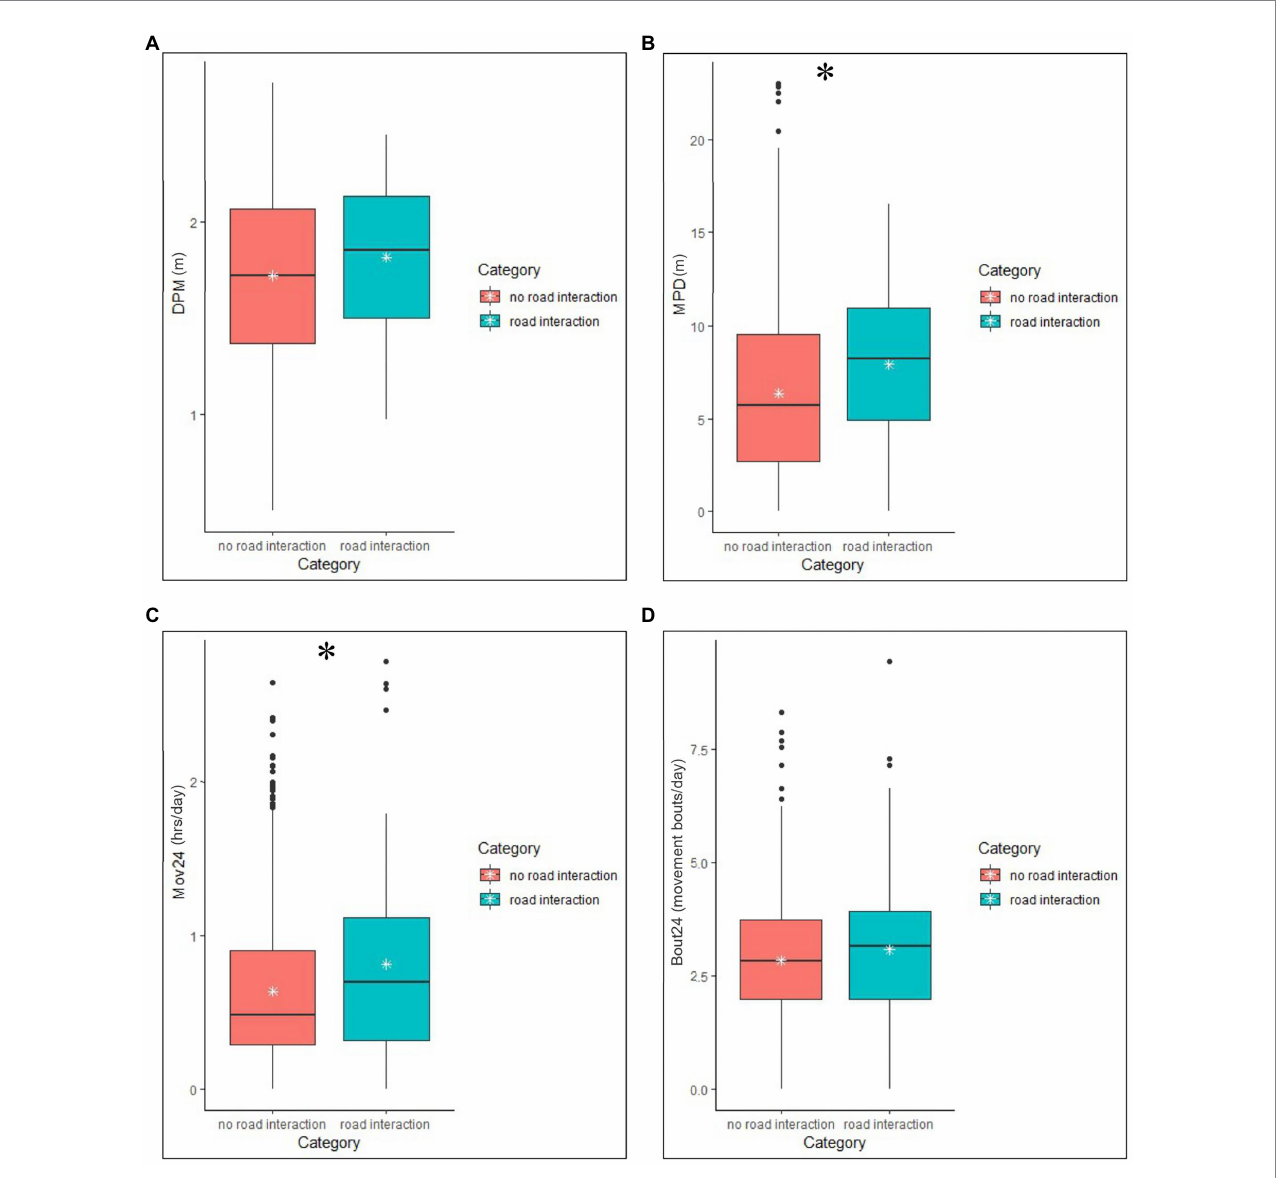
FIGURE 2 Minimum, median, and maximum values and the interquartile range of road interactions and no road interactions in Crotalus horridus RT and ACT movement metrics. The white stars on the graphs represent the mean of each category. RT derived movement measures (A,B) include Distance Per Movement (DPM) and Meters Per Day (MPD). ACT derived movement measures (C,D) include the mean time spent moving per 24 h (Mov24) and the mean number of movement bouts per 24 h (Bout24). Asterisks denote significant differences ( p <